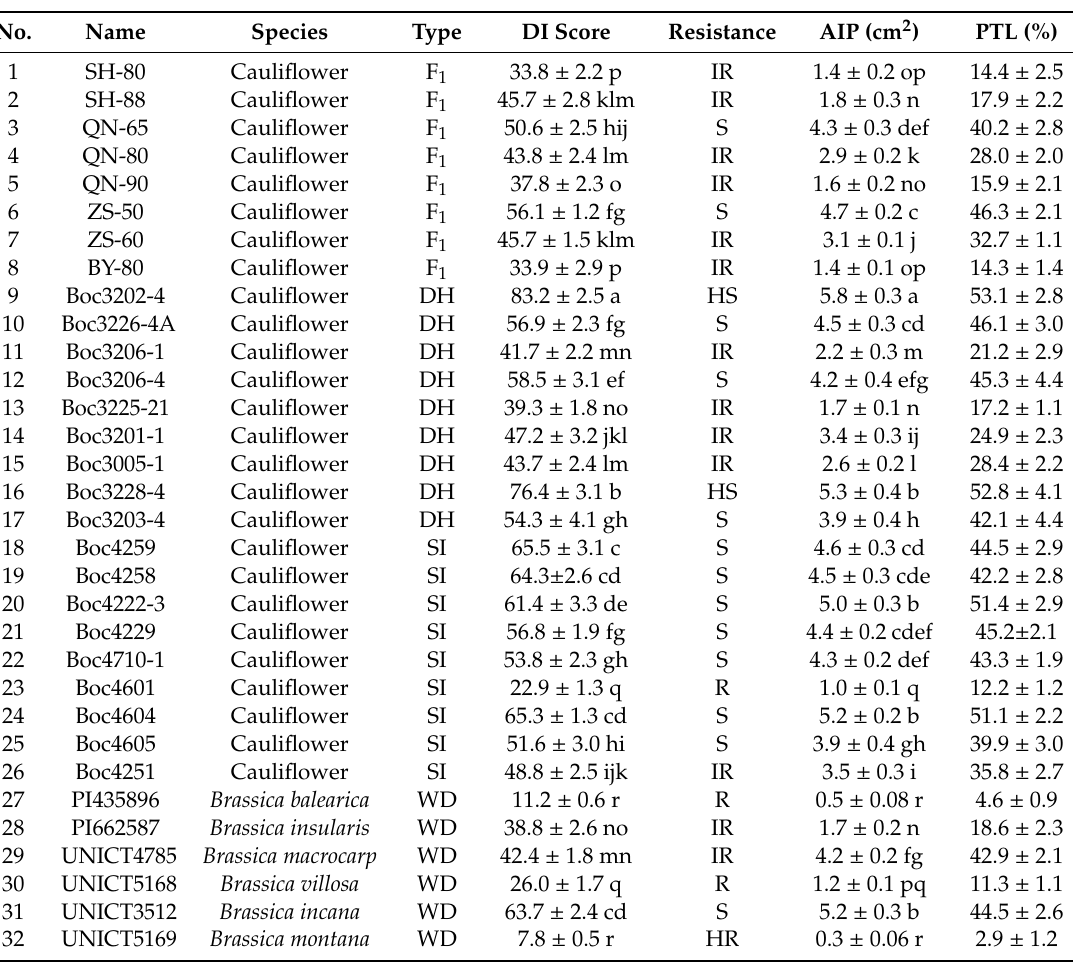
Table 1. Investigation of Xanthomonas campestris pv. campestris race 4 ( Xcc 4) Resistance of Di ff erent B. oleracea